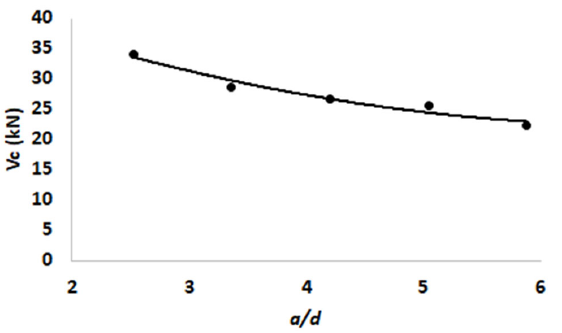
Figure 13. The effect of span to depth ratio ( a/d ) on the shear strength of the HVFA ‐ SCC